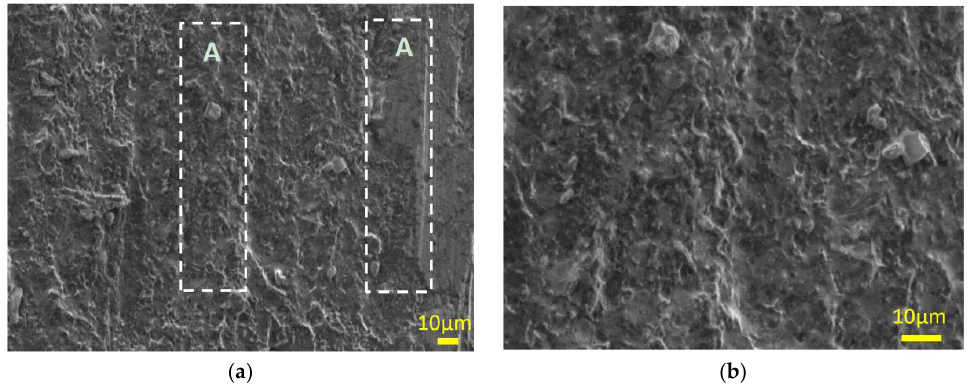
Figure 15. SEM image from kissing bond location: ( a ) 500×; and ( b ) 1000×.